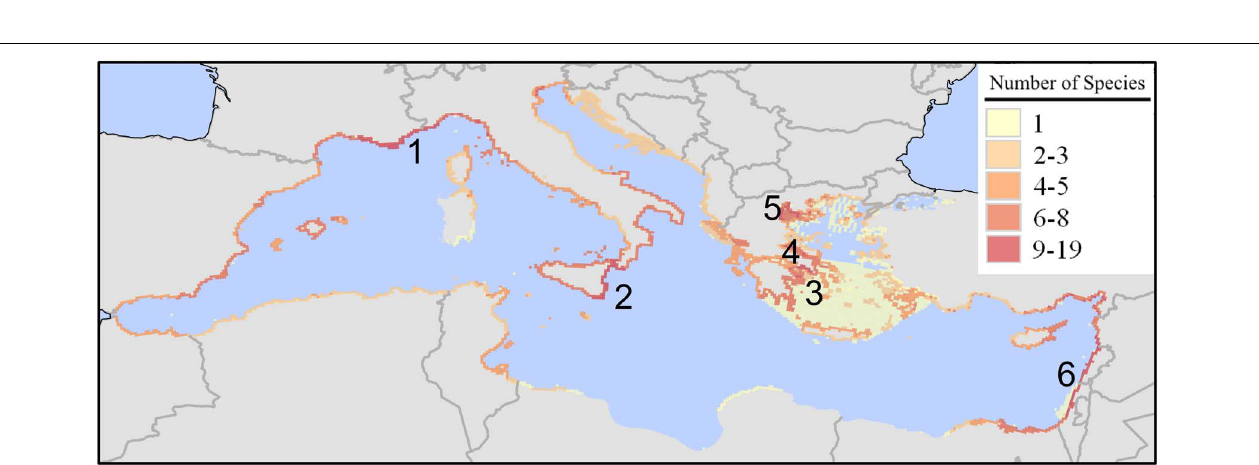
FIGURE 3 | Richness (number of species in a 10 × 10km grid) of marine alien species introduced in the Mediterranean Sea by shipping. Map was produced by EASIN’s mapping widget. High-richness areas: (1) north-western